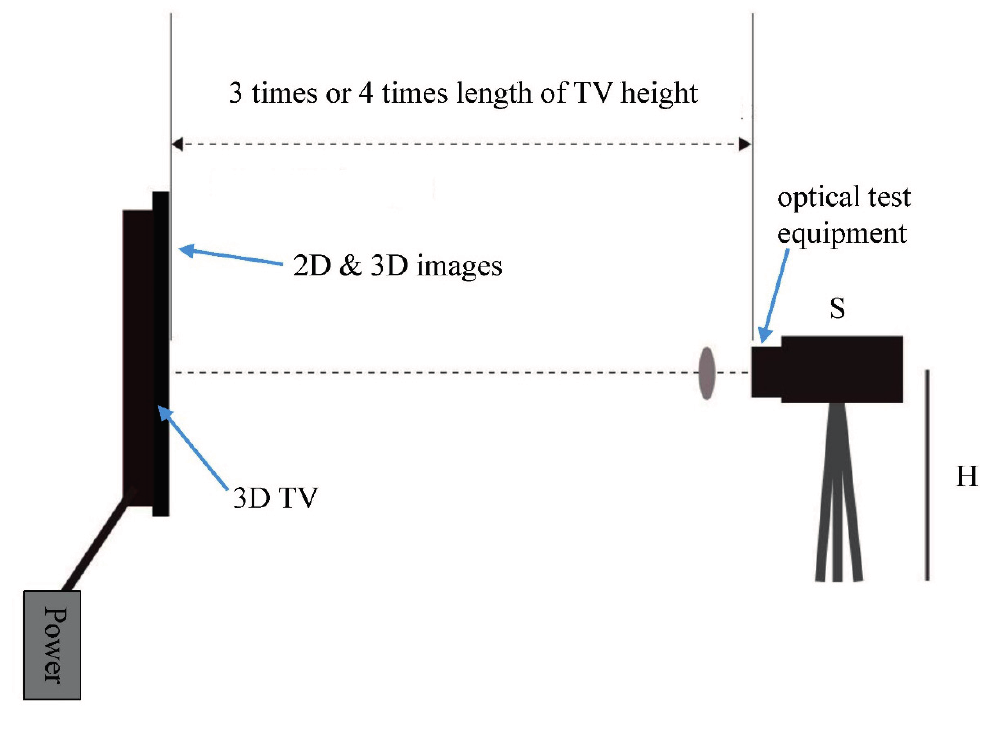
Figure 6. Schematic of darkroom for display brightness measurement